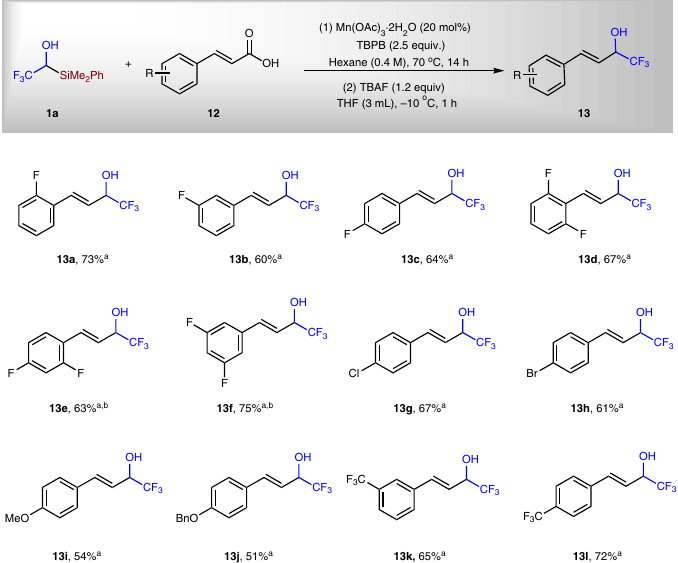
Fig. 6 Synthesis of α -tri fl uoromethylated allylic alcohols. a Reactions were run under standard conditions with 1a / 12 = 1/2. b DCM was used as solvent instead of hexanes.